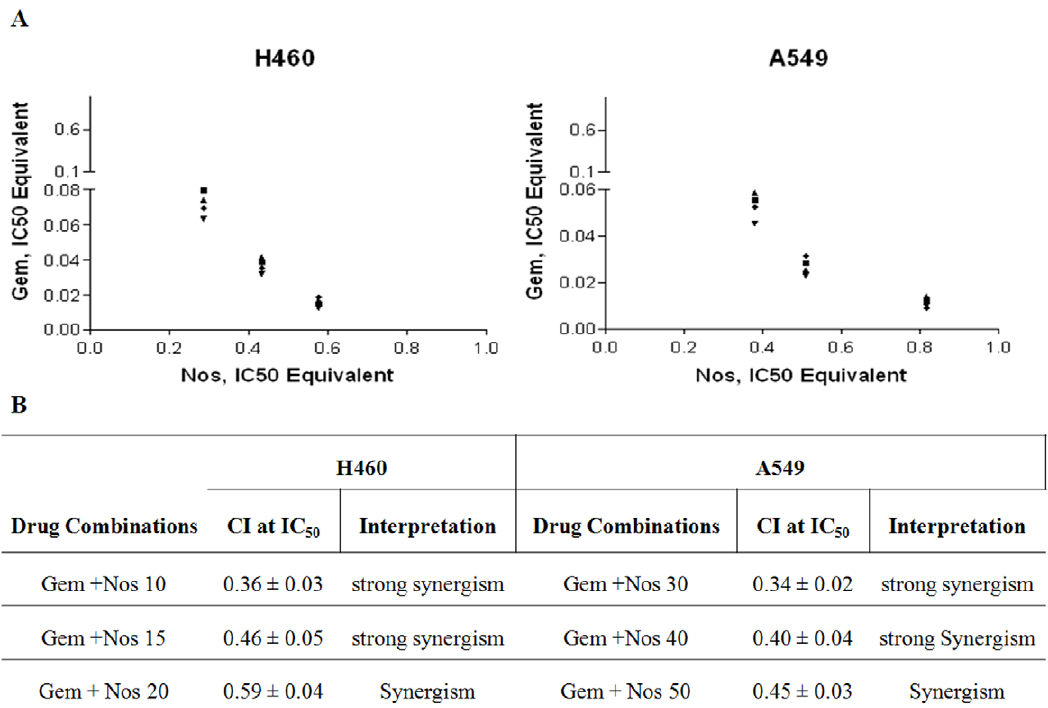
Figure 1. Isobolograms (A) and (B) Combination Index (CI) values of the interaction between Gem with Nos against human lung Cancer cells. Different concentrations of Nos were employed to study the effect on IC50 of Gem. Variable ratios of drug concentrations and mutually non-exclusive equations were used to determine the CI. The CI values represent mean of four experiments. CI . 1.3: antagonism; CI 1.1–1.3: moderate antagonism; CI 0.9–1.1: additive effect; CI 0.8–0.9: slight synergism; CI 0.6–0.8: moderate synergism; CI 0.4–0.6: synergism; CI 0.2–0.4: strong synergism.